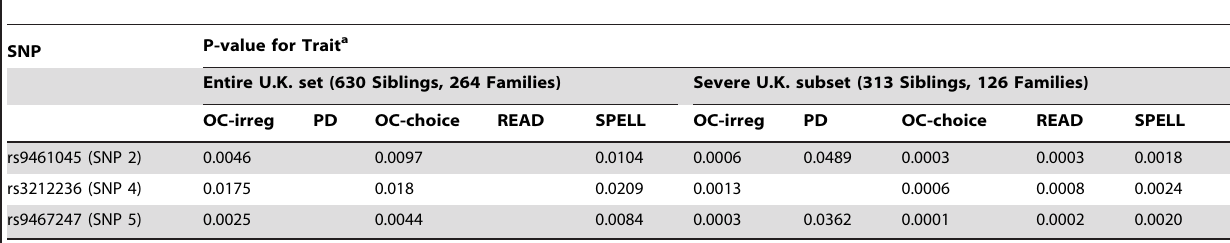
Table 1. Genetic associations for markers genotyped in selected U.K. sample